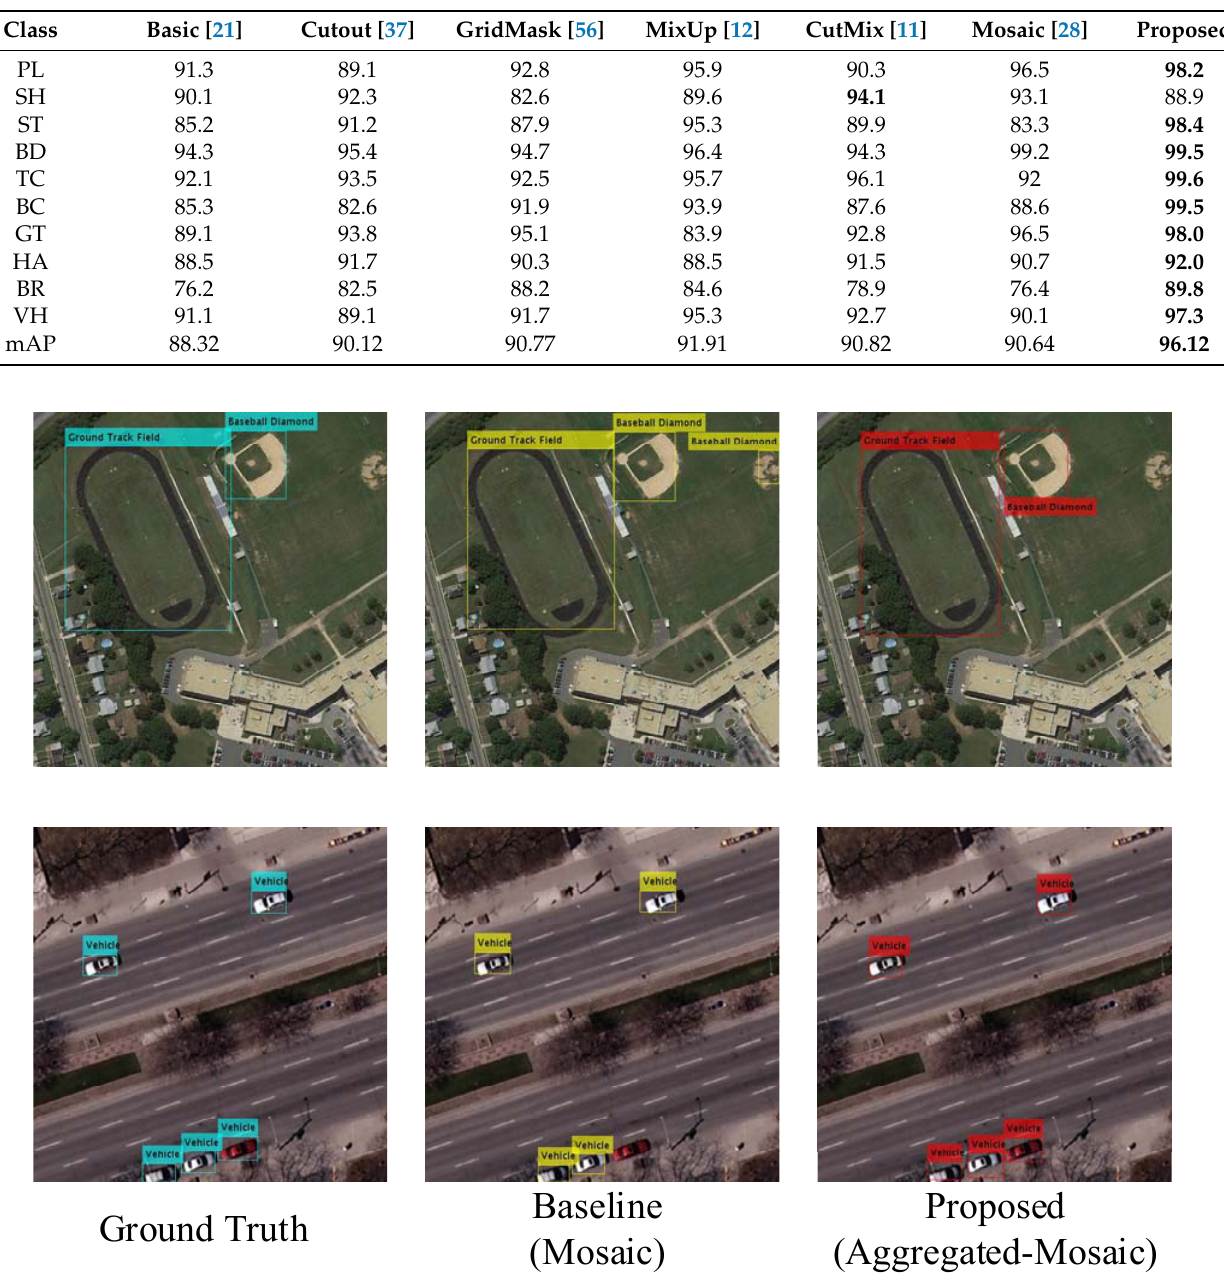
Table 4. Results of NWPU-VHR 10.